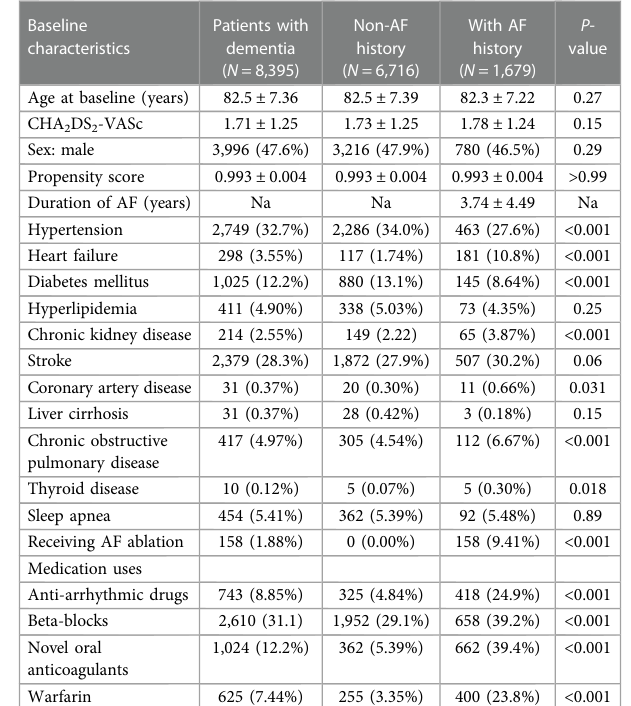
TABLE 1 Baseline characteristics of patients with dementia (after